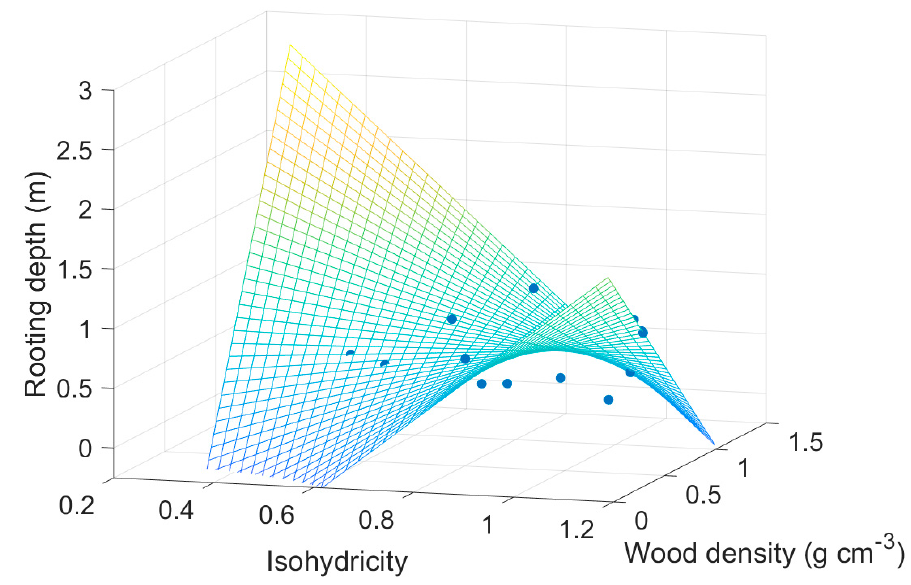
Figure 3. Multiple linear regression demonstrating potential trait-space described by rooting depth, isohydricity, and wood density ( R 2 = 0.24, p = 0.42 *not significant). Markers represent individual species ( n = 23).